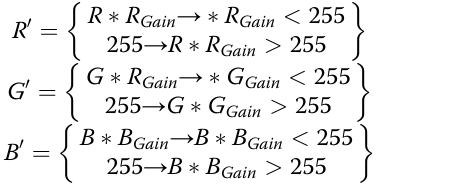
dated. So far, the automatic white balance algorithm based on image color cast detection is completed.